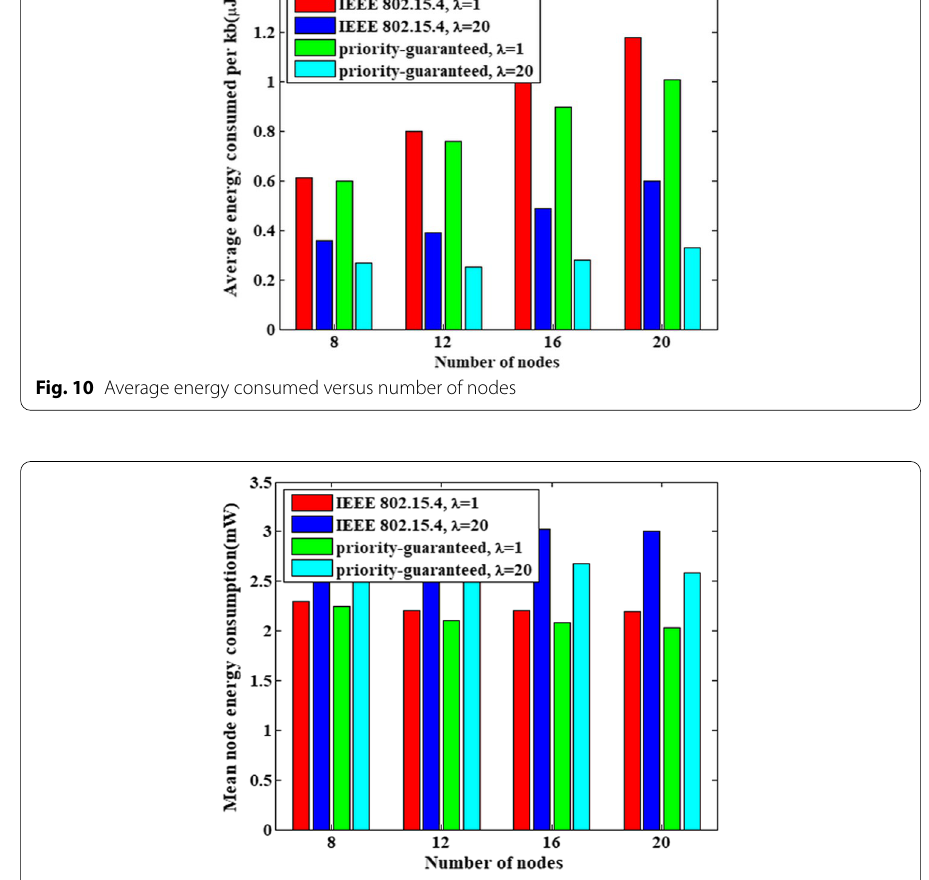
Fig. 11 Mean node energy consumption against the number of